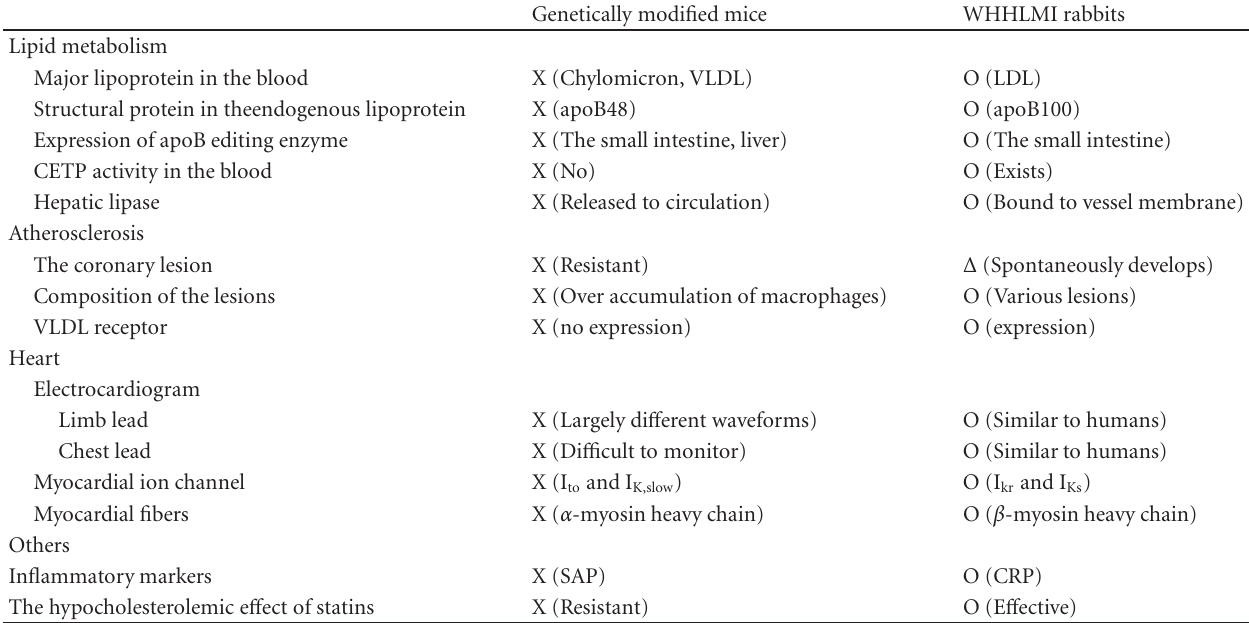
Table 1: Comparison of lipid metabolism, atherosclerosis, and cardiac functions between genetically modified mice and WHHLMI rabbits. Genetically modified